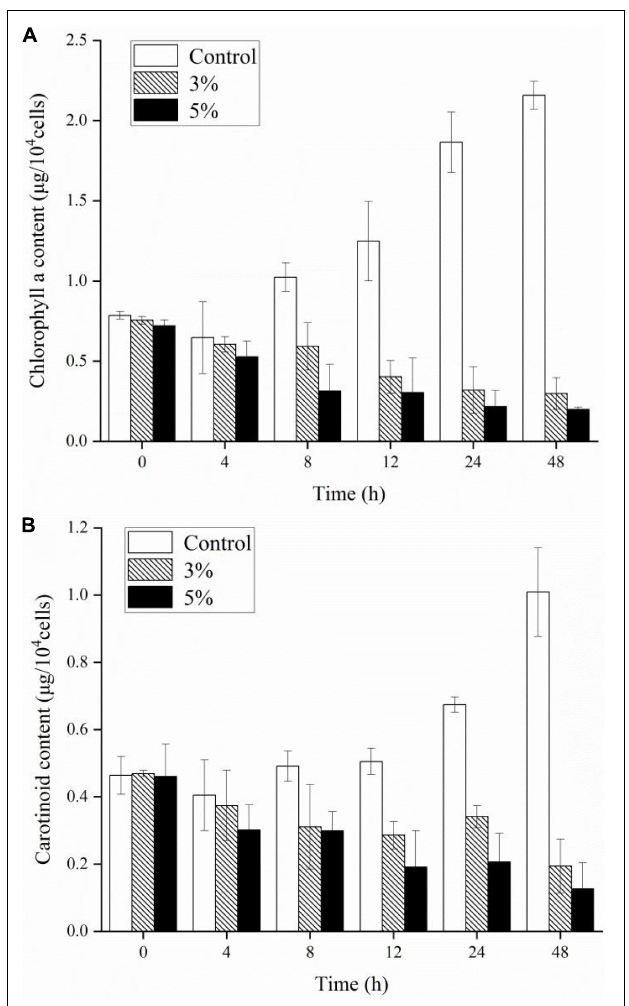
FIGURE 3 | Effects of different doses of Paracoccus homiensis O-4 on the Chl a (A) and carotenoid contents (B) in K. mikimotoi . Error bars represent the standard deviation of the triplicates.